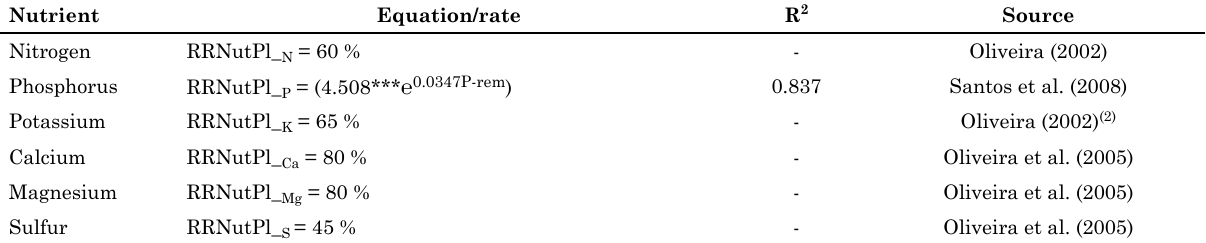
***: significant at 0.1 %; (1) The values shown above are drawn from studies on other crops due to the lack of specific information for the melon crop. The RRNutPl values for melon are probably greater than those presented because the current use of fertigation facilitates the uptake of nutrients by the crop and increases efficiency in the use of fertilizers. Therefore, these values are considered as minimum values to be adopted; (2) approximate